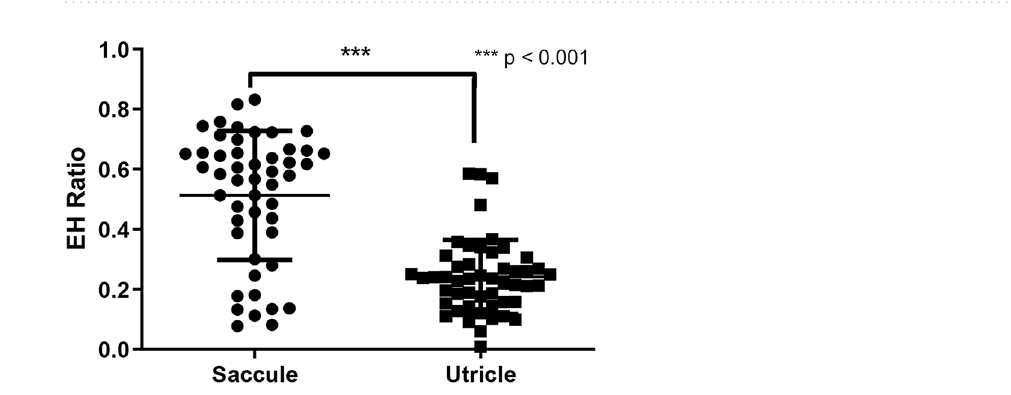
Figure 2. Comparison of histopathology and MRI endolymphatic hydrops (EH) ratios in affected ears. The mean values for the EH of affected ears in the cochlea ( a ) and vestibule ( b ) were not significantly different between histopathology and MRI.